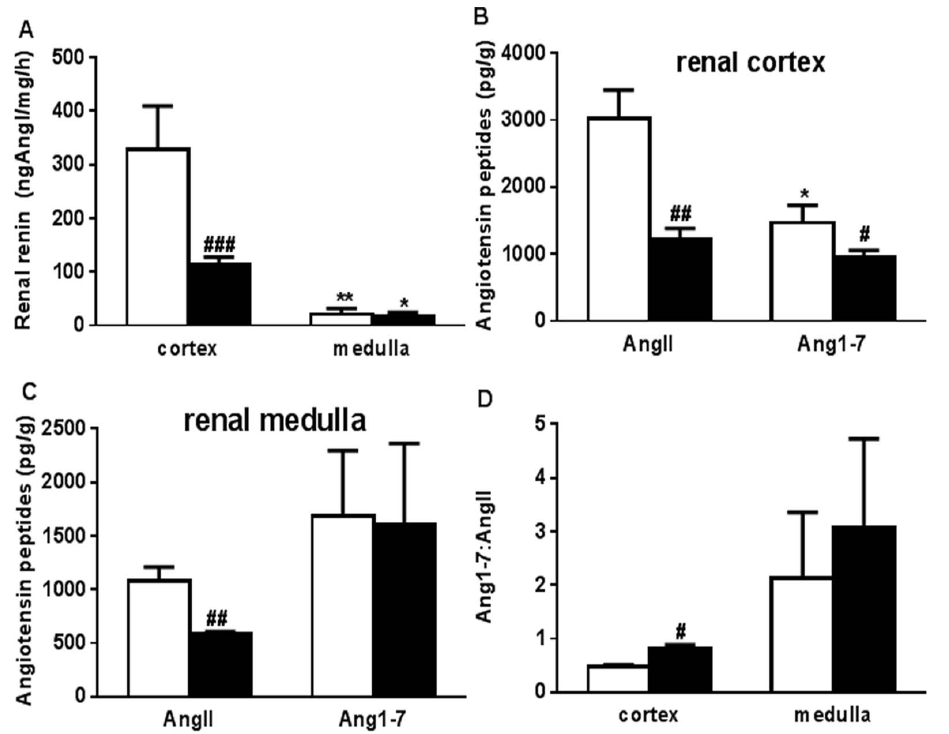
Figure 5. Renal tissue (A) renin content, angiotensin peptide (Angiotensin II (AngII), Angiotensin 1–7 (Ang 1–7) content in the renal (B) cortex and (C) medulla, and (C) Angiotensin 1–7:AngII ratio in sham and uni-x kidneys at 5 years of age. Sham (white bars, N=5) and uni-x (black bars, N=5). Values are mean 6 SEM. # P , 0.05, ## P , 0.01, ### P , 0.001 comparing sham and uni-x groups and *P , 0.05, **P , 0.01, comparing kidney zones within the sham and uni-x group from Bonferroni post-hoc